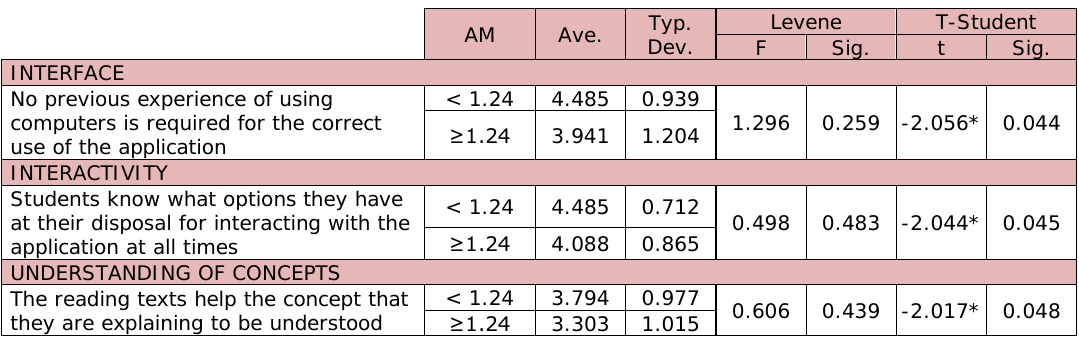
Table 8. “Independent-Samples t-Student test according to gender”.